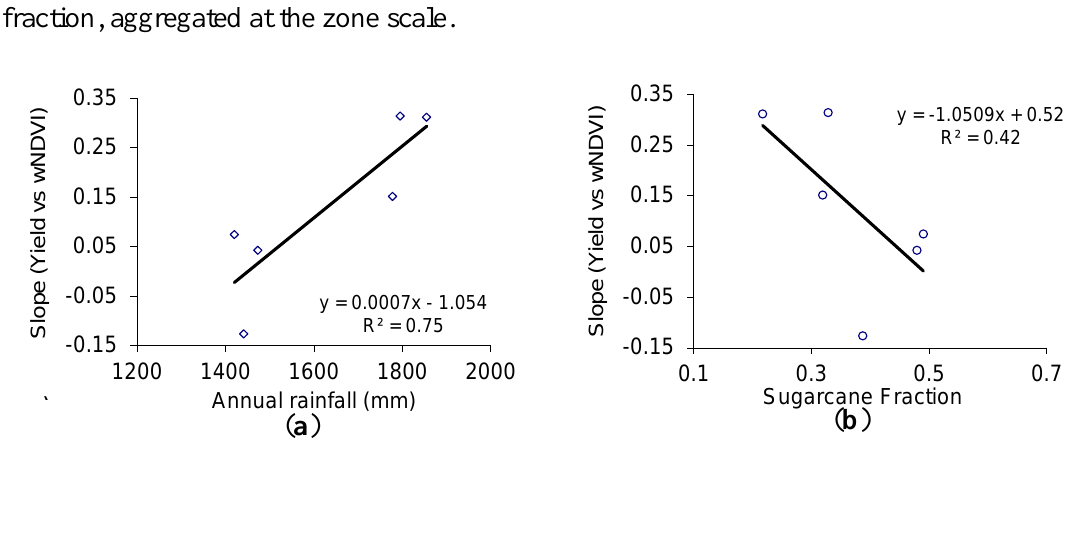
Figure 7. Relationship between the “yield-wNDVI” slope and ( a ) rainfall, and ( b ) sugarcane fraction, aggregated at the zone